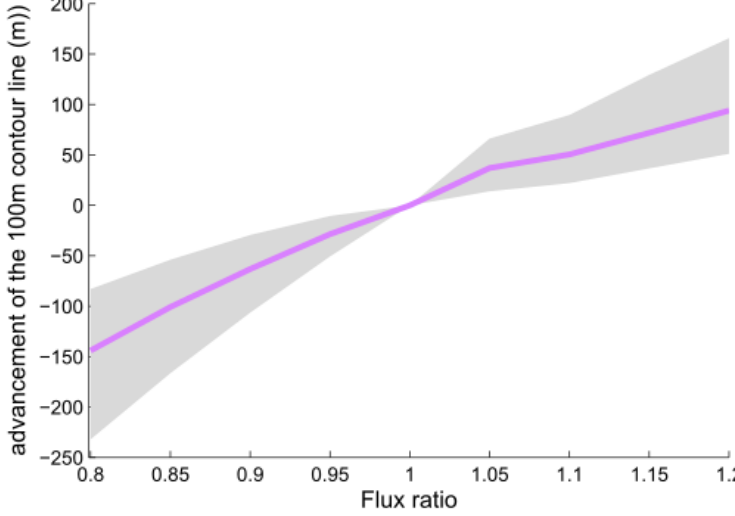
Figure 6. Seawater/freshwater interface position with respect to rate of flux.